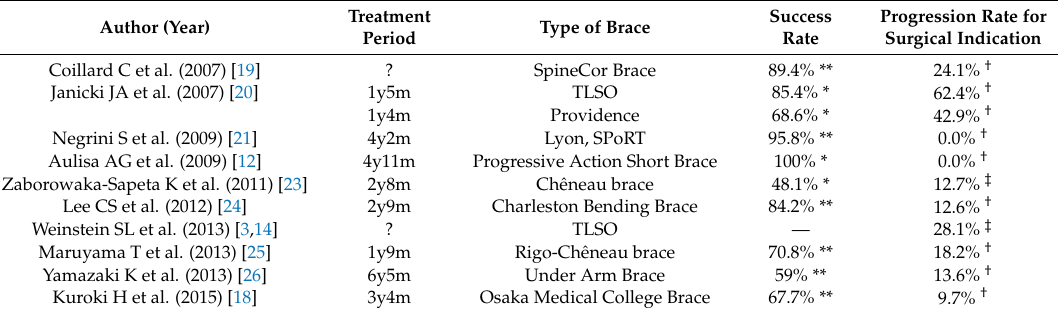
Table 1. Literature review of the clinical results under SRS criteria.